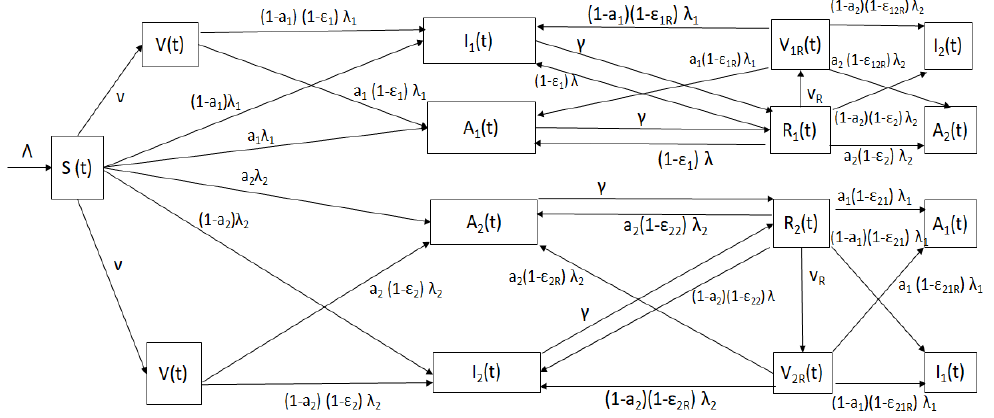
Figure 1. Diagram of the mathematical model (2) with classes and relevant